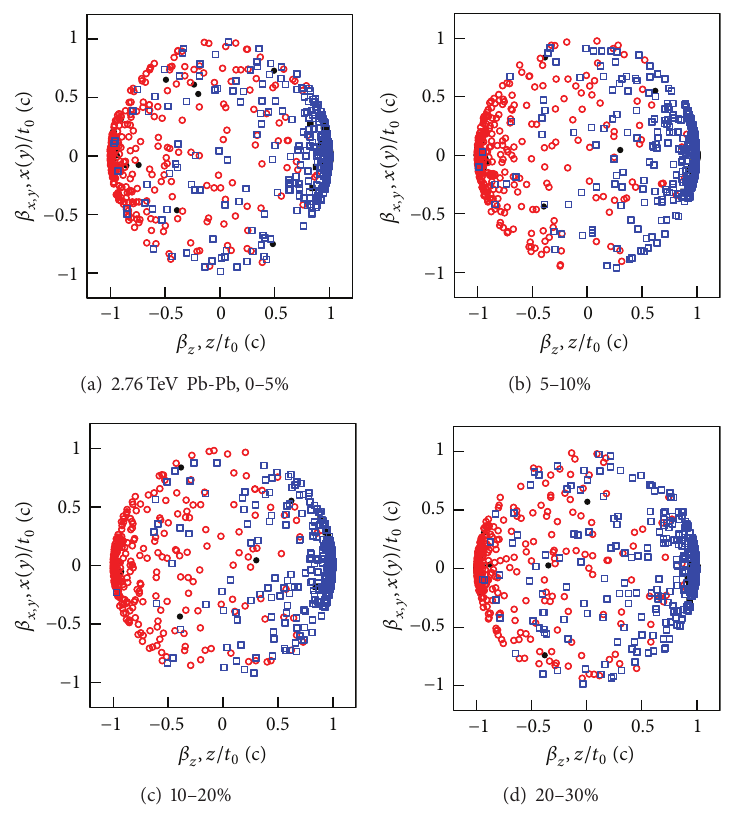
Figure 6: The same as for Figure 4, but showing the results in the velocity space 𝛽 𝑥 −𝛽 𝑧 (or 𝛽 𝑦 −𝛽 𝑧 ) or the rescaled coordinate space 𝑥/𝑡 0 −𝑧/𝑡 0 (or 𝑦/𝑡 0 − 𝑧/𝑡 0